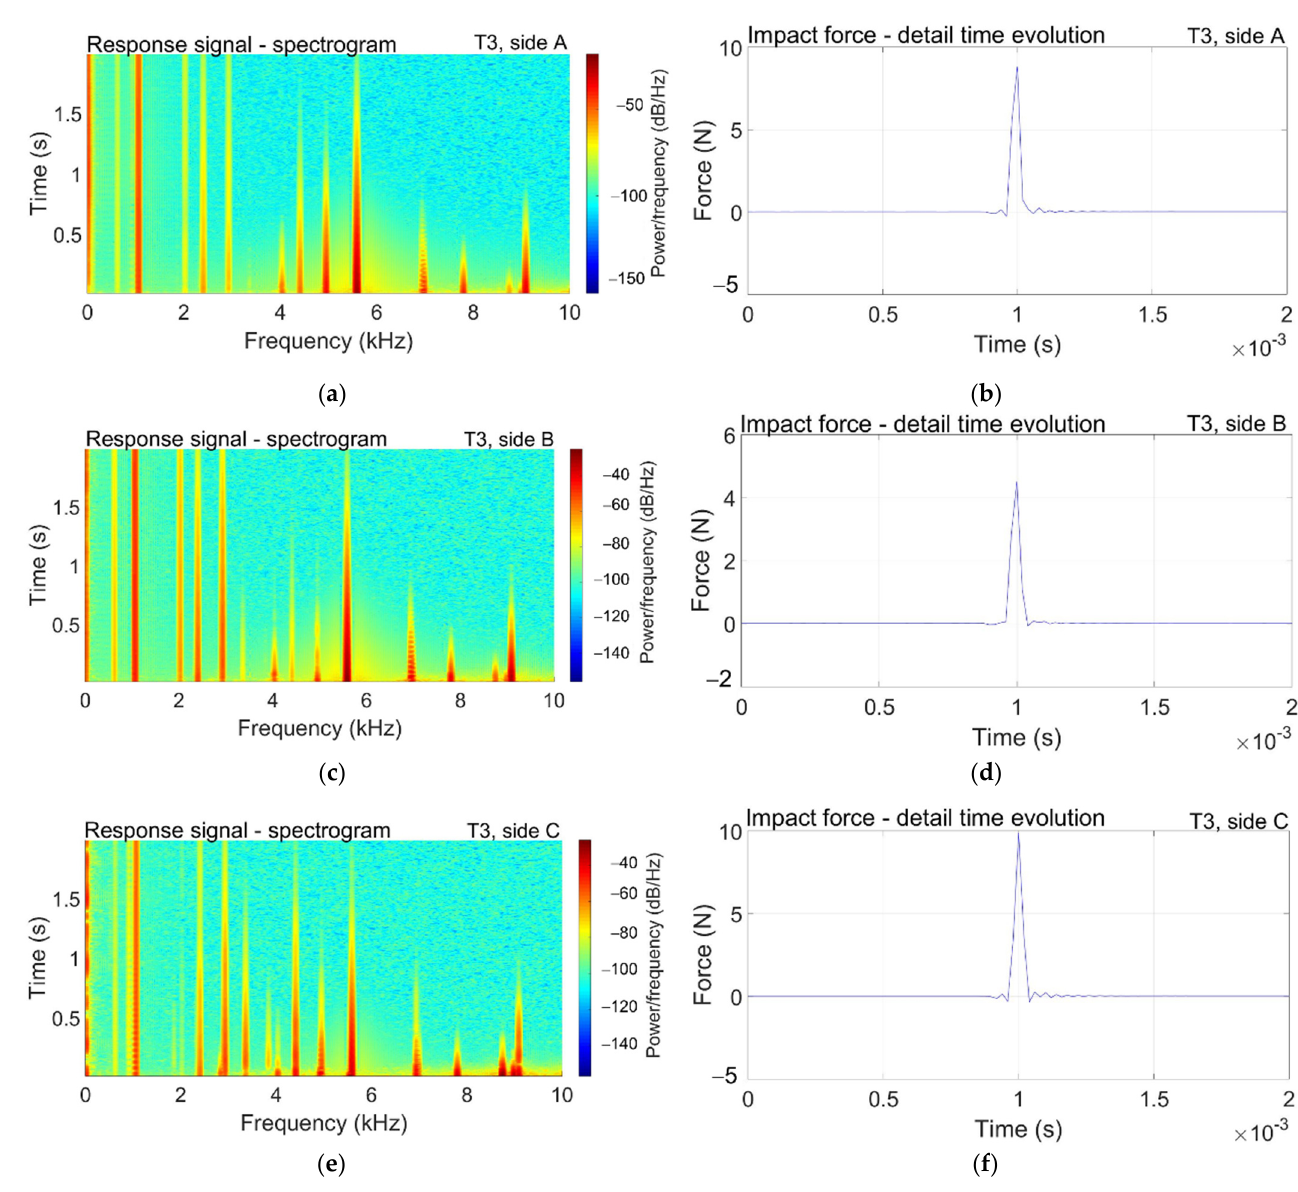
Figure 8 . The spectrograms and the graphs of impact force, for aluminum triangle T3: ( a ) in case of excitation of side A; ( b ) the plot of excitation force against the time, by hitting side A; ( c ) in case of excitation of side B; ( d ) the plot of excitation force against the time, by hitting side B; ( e ) in case of excitation of side C; ( f ) the plot of excitation force against the time, by hitting side C.